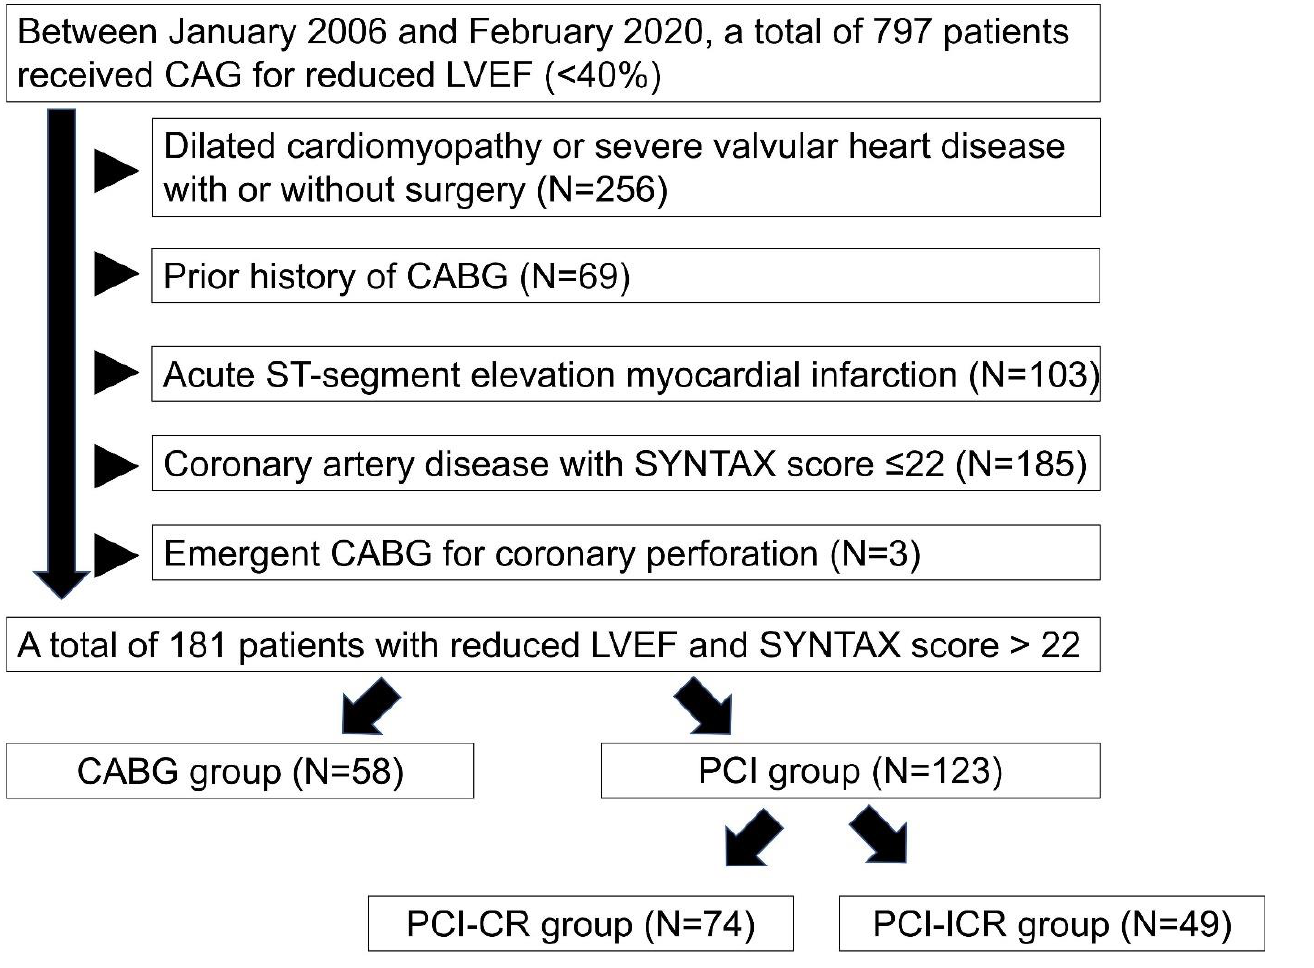
Figure 1. Flow chart of study population. Between 2006 February and 2020 February, a total of 797 patients received coronary angiograms due to left ventricular ejection fraction ≤ 40% in our hospital. We excluded patients of dilated cardiomyopathy or severe valvular heart disease with and without surgery ( n = 256), prior history of coronary artery bypass grafting (CABG) ( n = 69), acute ST-segment myocardial infarction ( n = 103), coronary artery disease with low SYNTAX score ≤ 22 ( n = 185) and emergent CABG for coronary perforation ( n = 3). Percutaneous coronary intervention group was classified into complete revascularization (CR) group (PCI-CR) ( n = 74) and incomplete-CR group (PCI-ICR) ( n = 49). Abbreviation: CAG: coronary angiography; LVEF: left ventricular ejection fraction; CABG: coronary artery bypass grafting; PCI: percutaneous coronary intervention; CR: complete revascularization; ICR: incomplete revascularization.